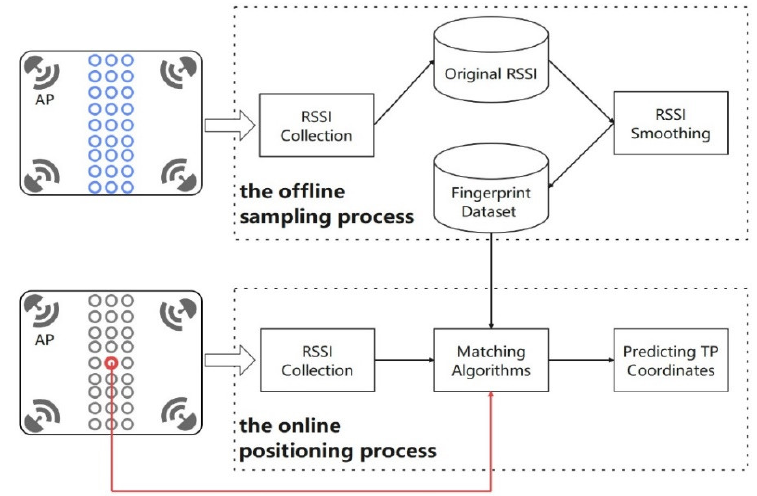
Figure 2. The flow chart of WIFI fingerprint positioning.